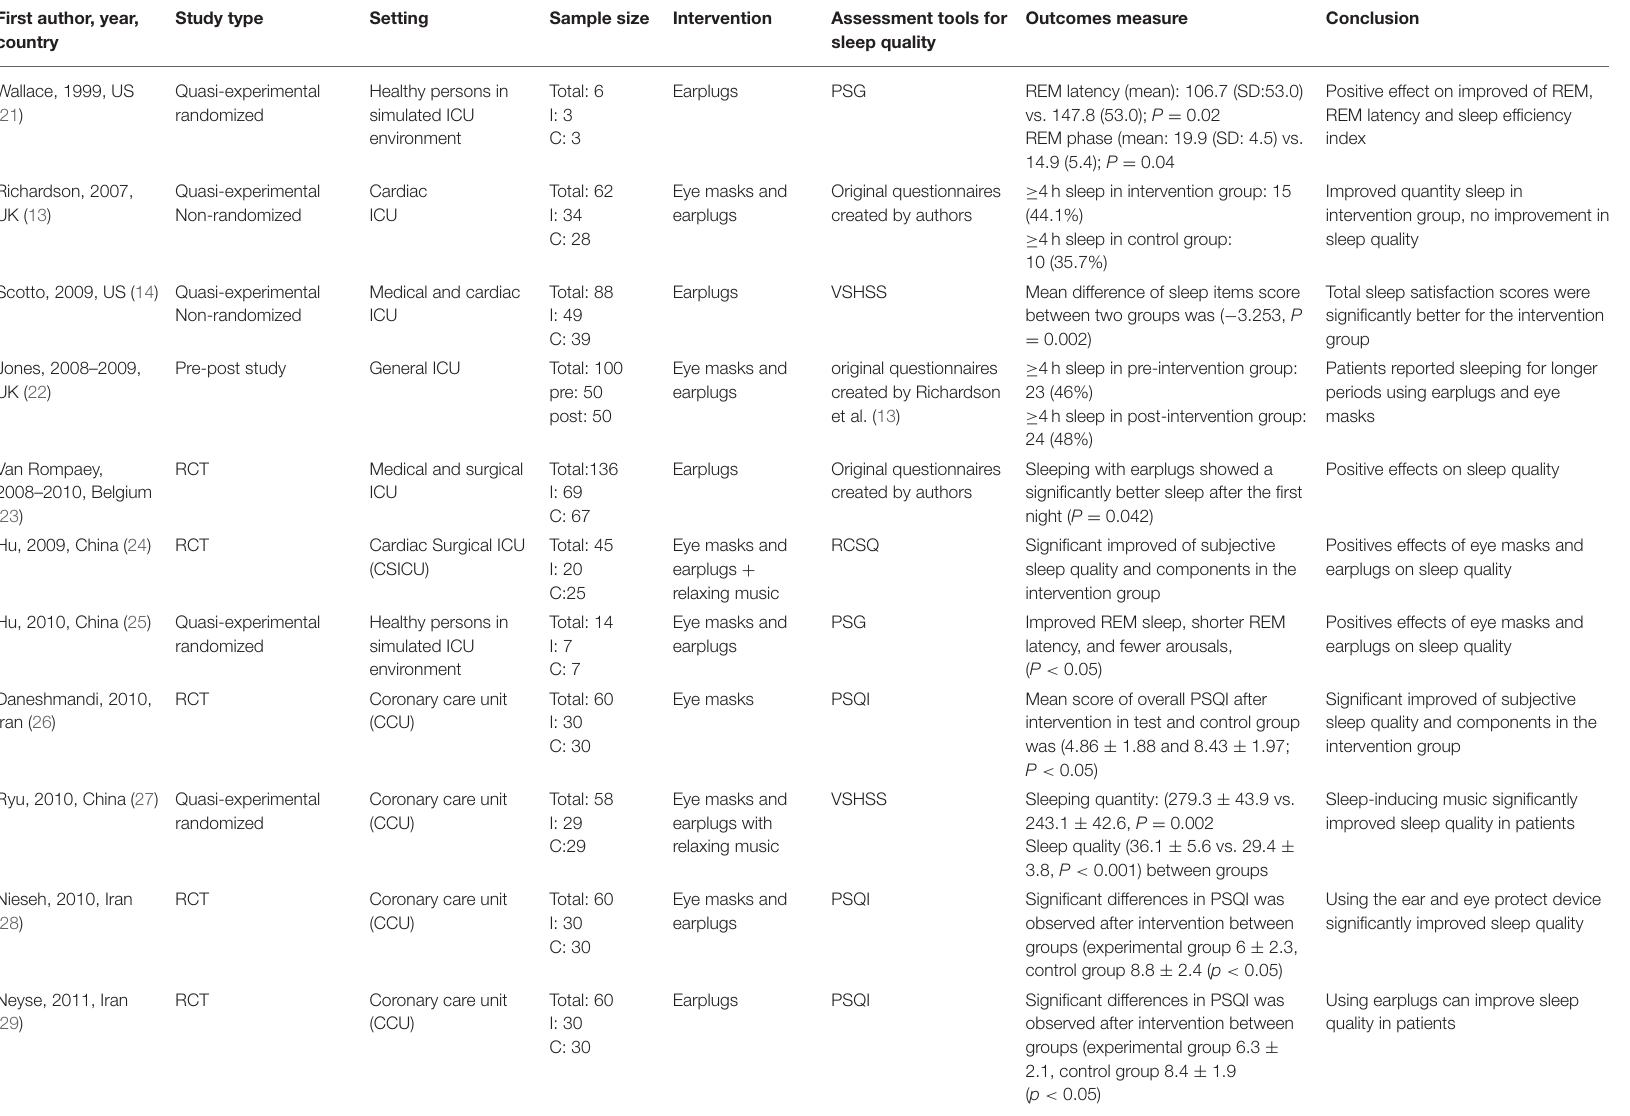
TABLE 1 | Characteristics and outcomes of all studies